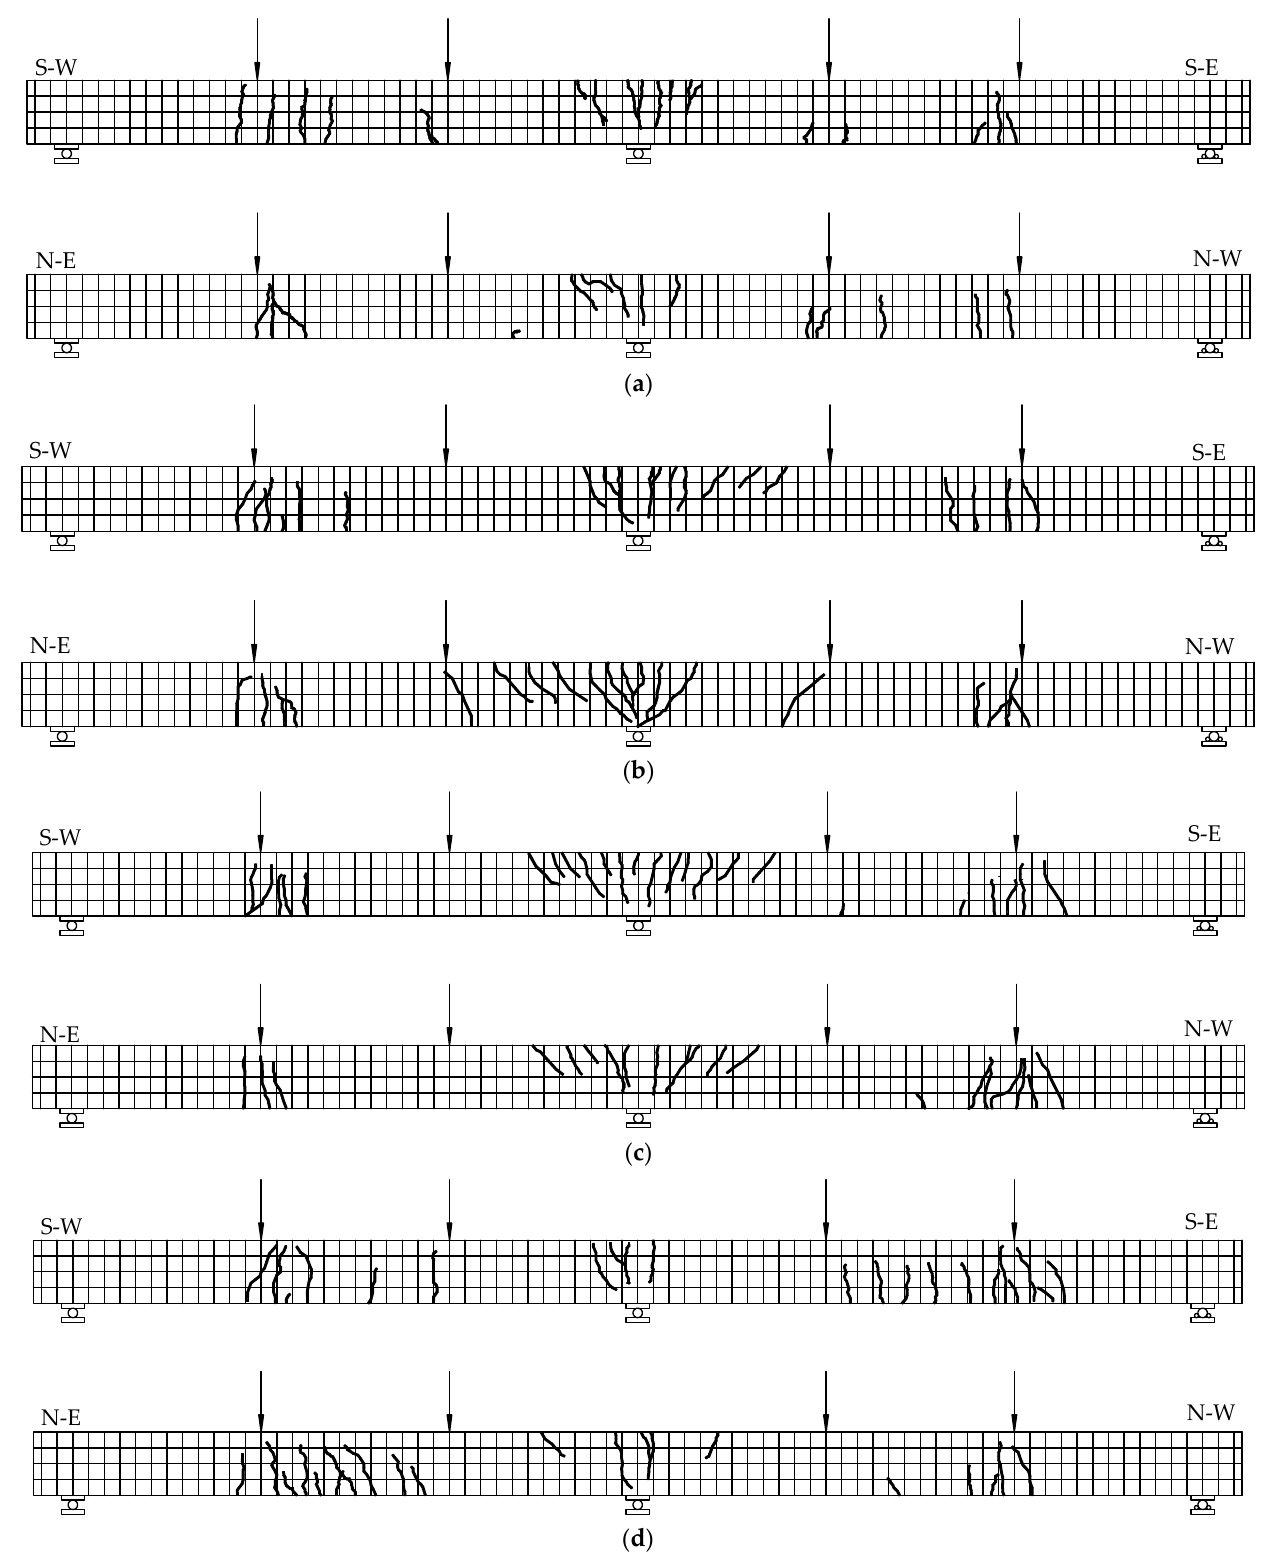
Figure 10. Crack development and failure pattern of the continuous beam under static load test failure after the fire: ( a ) CB-1; ( b )CB-2; ( c ) CB-3; ( d ) CB-4.